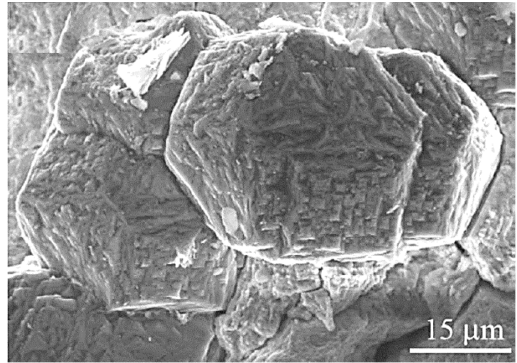
Figure 1. SEM secondary electron image of graphite octahedrons (cliftonite) from the Canyon Diablo iron meteorite; reproduced from [1] with permission from MDPI, 2019.